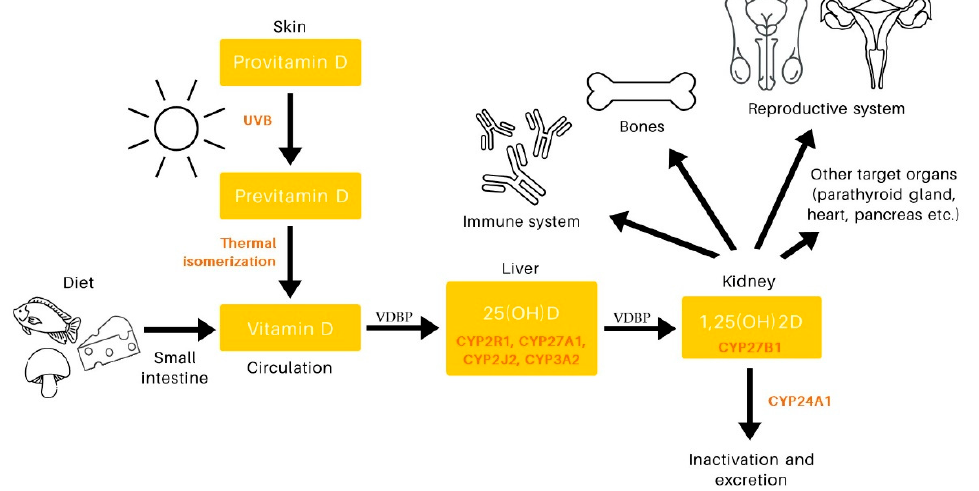
Figure 1. Overview of the vitamin D pathway. The main endogenous source of vitamin D is sunlight, which stimulates the synthesis of previtamin D3. Vitamin D can also be absorbed in the intestines from food. From the skin or intestines, vitamin D goes into the blood where it is bound to protein. It is then hydroxylated in the liver and kidneys to produce 1,25-dihydroxyvitamin D, a physiologically active form of vitamin D that functions in many parts of the body, including the skeletal system, immune system, reproductive system, and others. Abbreviations: CYP: cytochrome P-450; UVB: ultraviolet B; VDBP: vitamin D-binding protein.